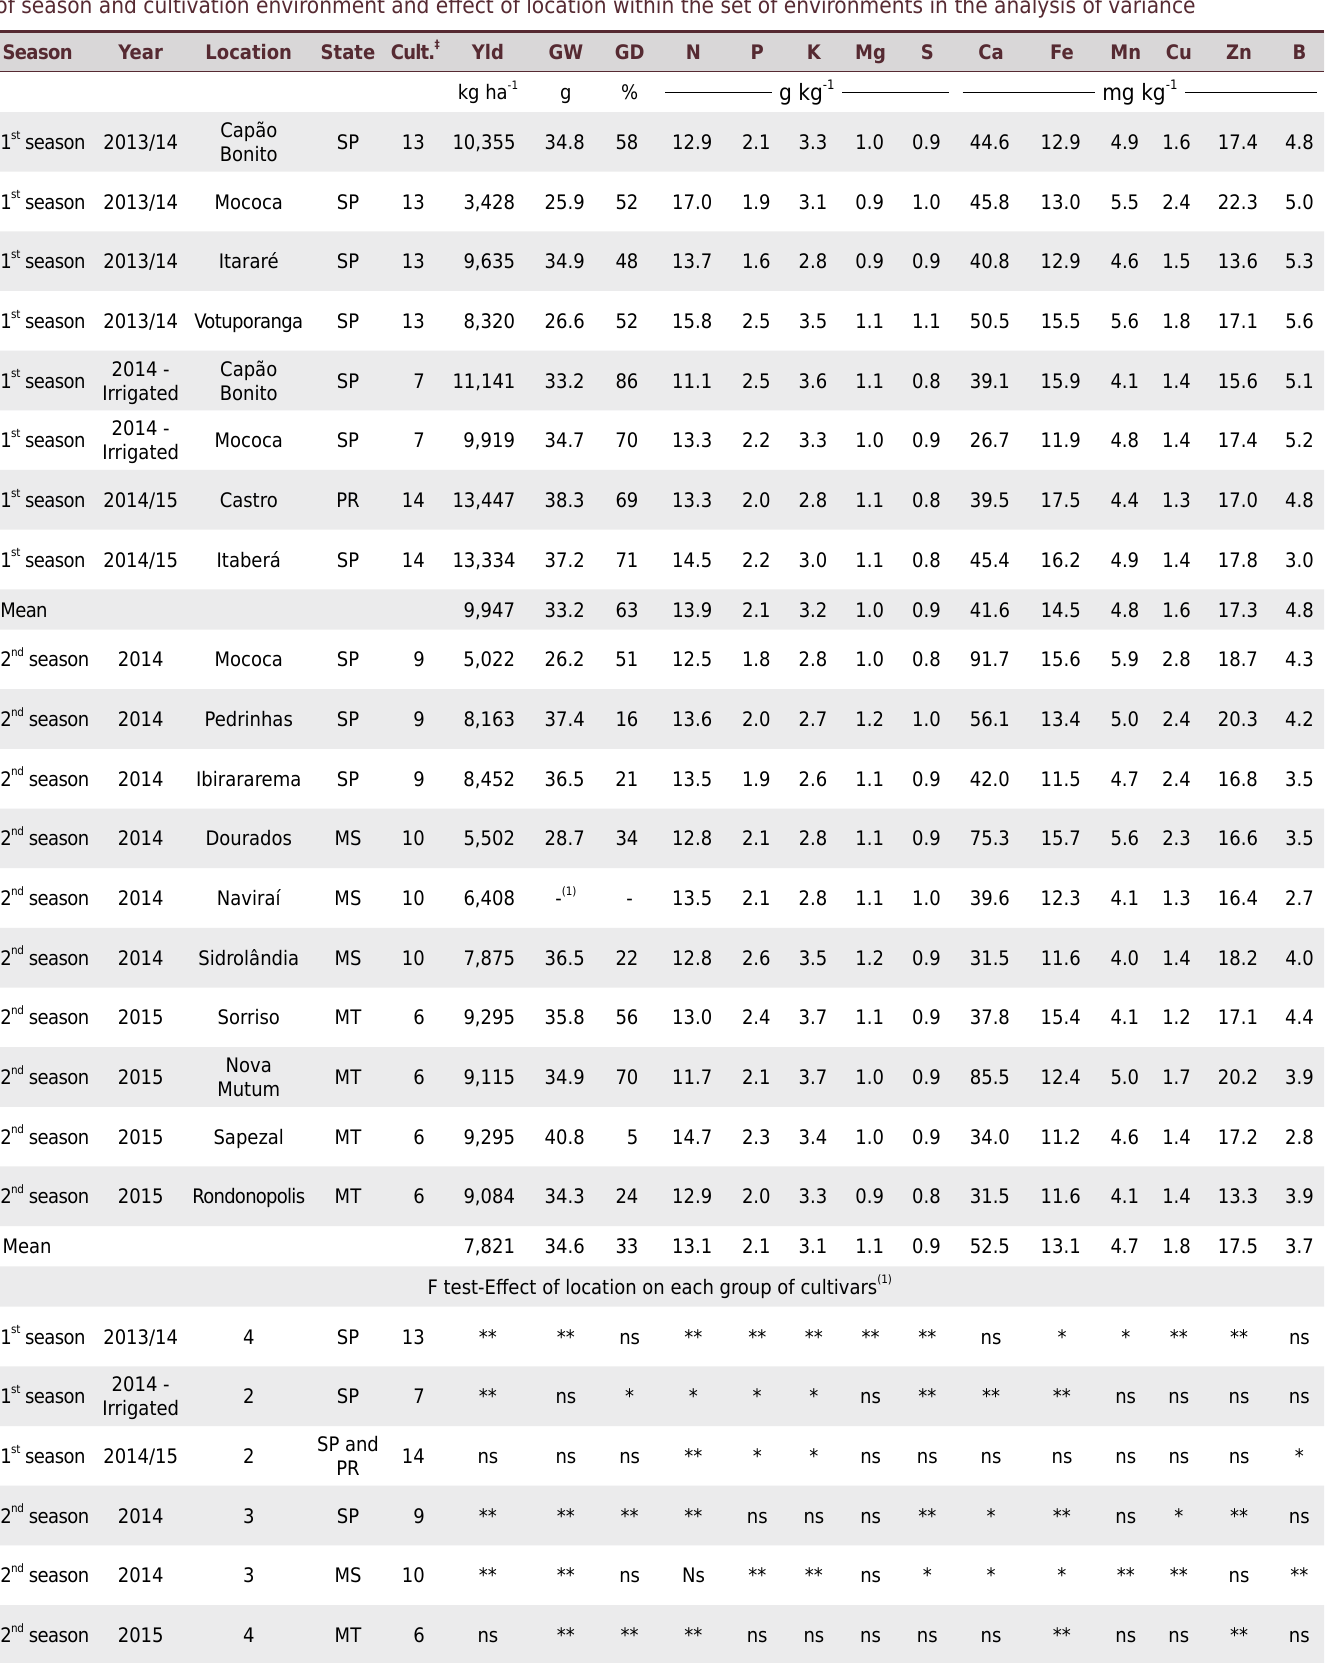
Table 2. Values of yield (Yld), 100-grain weight (GW), grain density by the floaters test (GD), and mineral nutrient contents in function of season and cultivation environment and effect of location within the set of environments in the analysis of variance